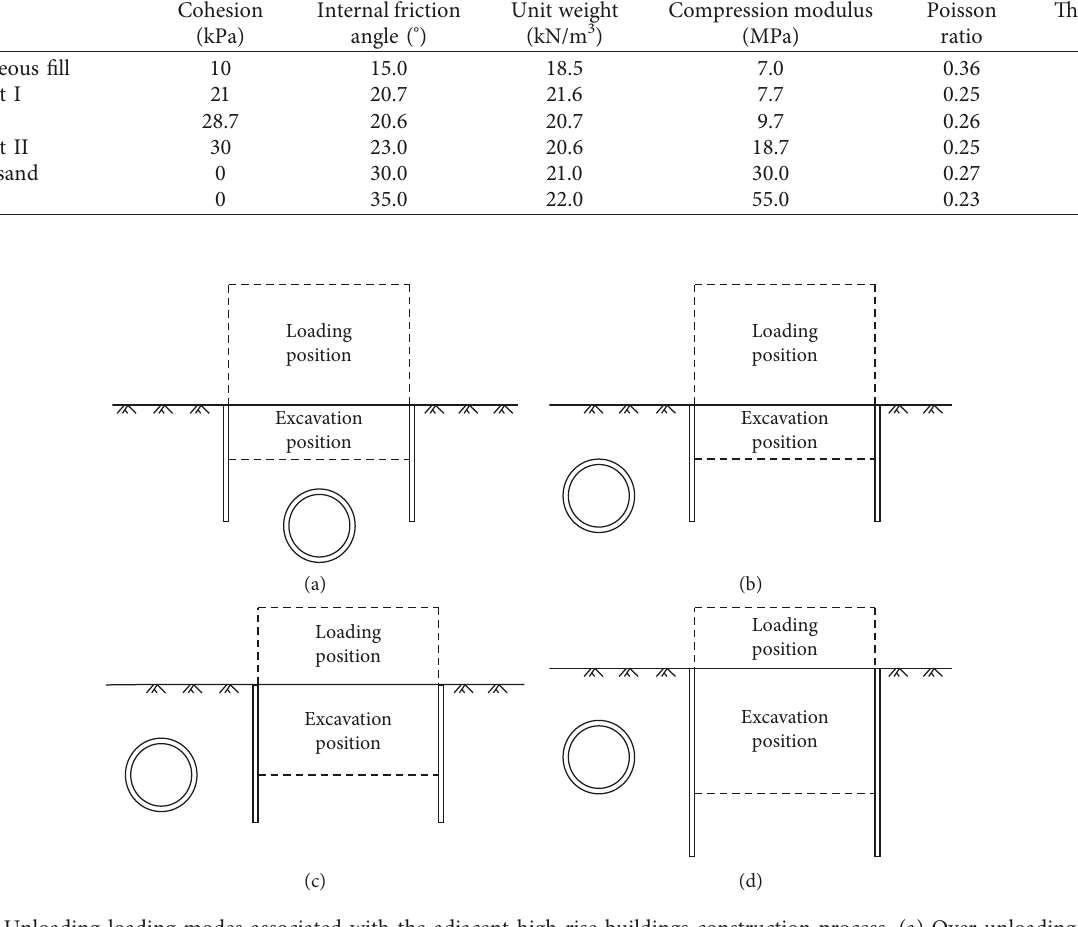
Table 1: Basic parameters of the typical engineering